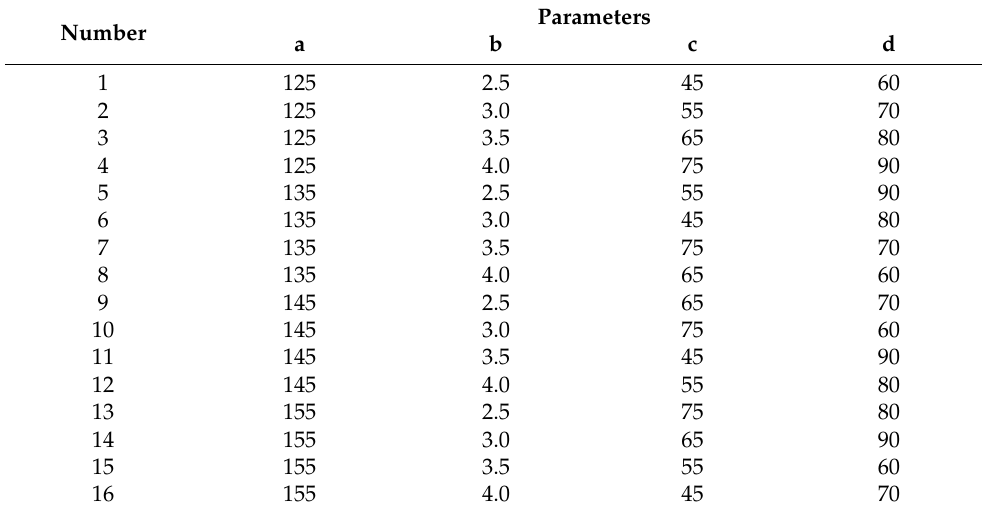
Table 12 is the orthogonal grading design test table. Table 12. Marshall orthogonal test scheme of EC-120-modified WMA